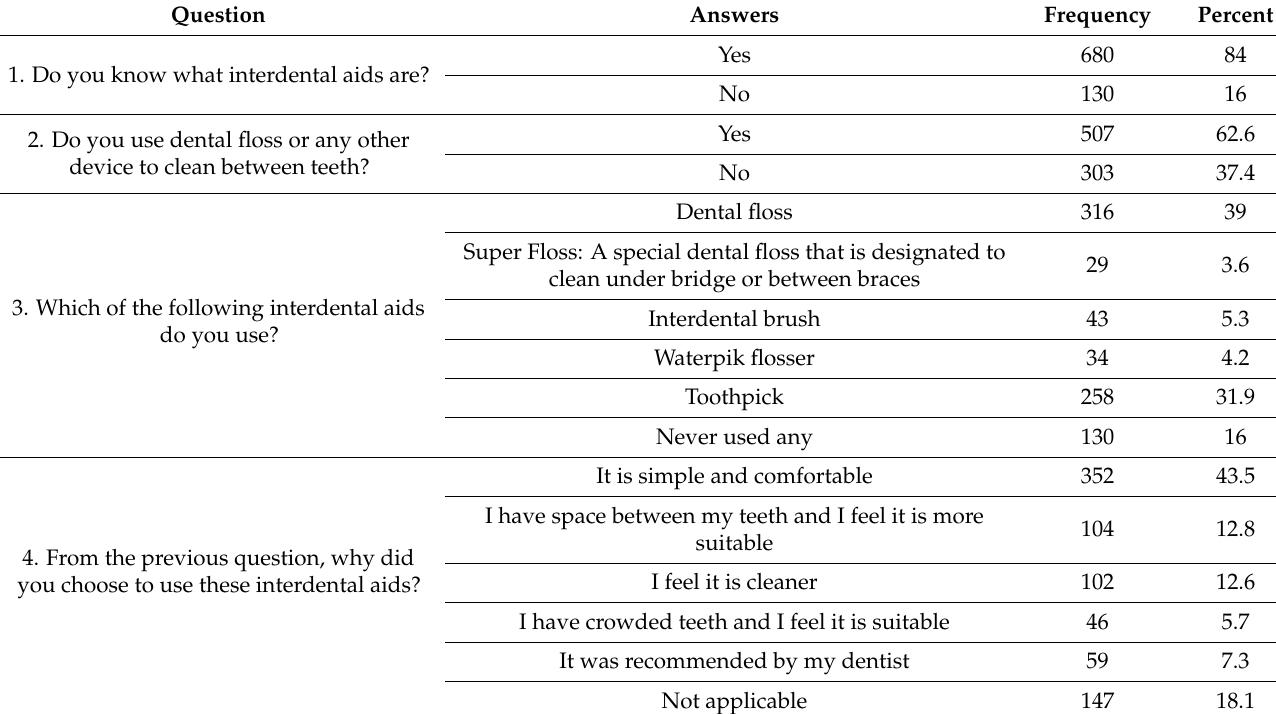
Table 6. Distribution of perception and knowledge on the use of interdental aids and mouthwash among the Saudi Arabian